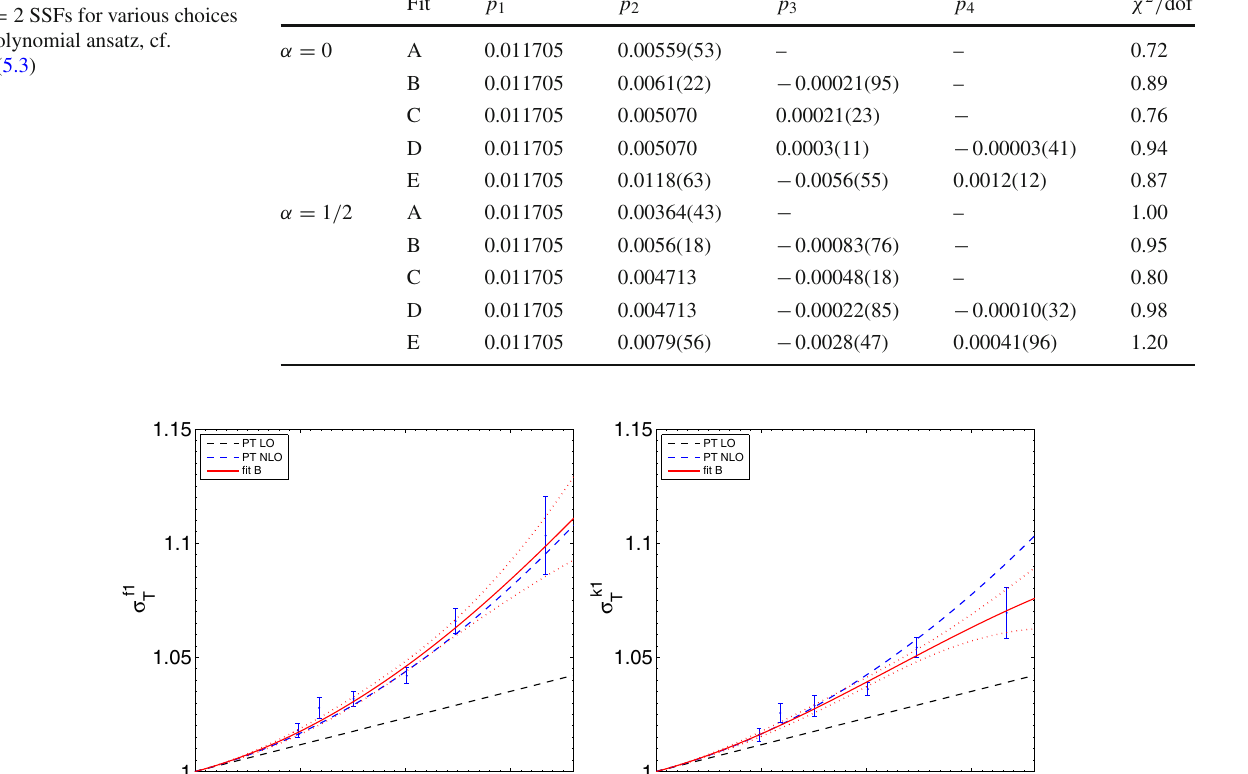
Fig. 8 Slopes of the continuum limit extrapolation of (cid:10) subtracting one-loop cutoff effects